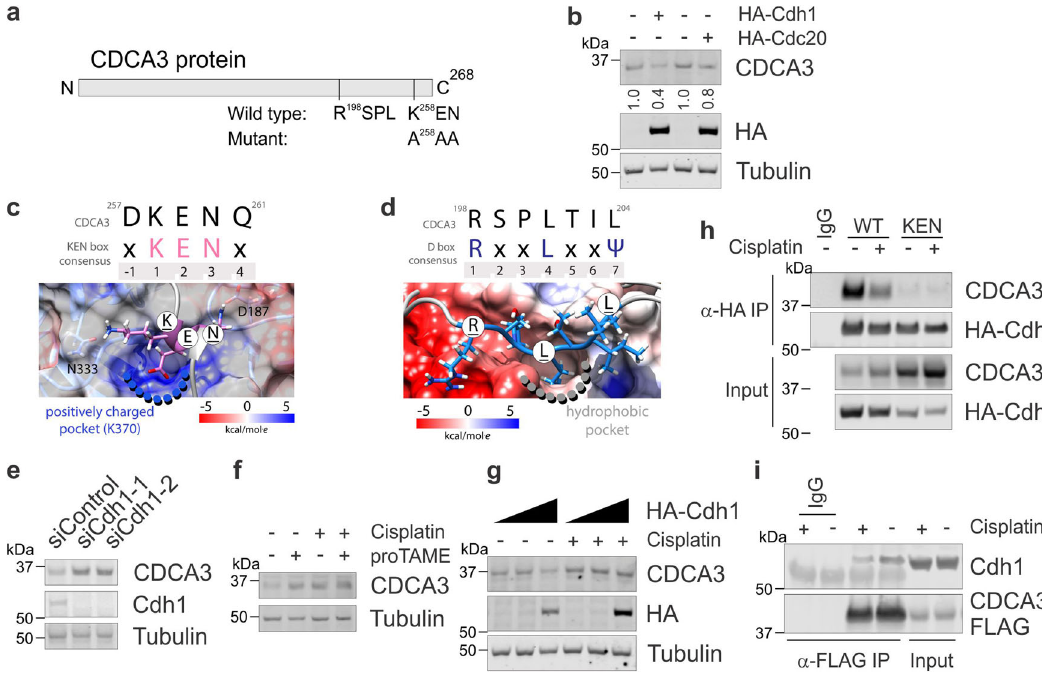
Fig. 3 CDCA3 avoids APC/C Cdh1 -mediated degradation following exposure to cisplatin. a Schematic of primary CDCA3 protein sequence listing C- terminal D-box (RxxL) and KEN box motifs. KEN box mutated to A 258 AA also indicated. b Endogenous CDCA3 western blot analysis of H460 cells ectopically expressing increasing levels of HA-Cdh1 or HA-CDC20. Tubulin used as loading control and HA probe to determine ectopic Cdh1 or CDC20 expression. c , d In silico models of the CDCA3 KEN box ( c ) and D-box ( d ) bound to Cdh1. Snapshots were taken after 300 ns of molecular dynamics simulation. Upper, CDCA3 protein sequence compared with consensus motifs. X = any amino acid, Ψ = aliphatic amino acid. Numbers indicate amino acid position within motif. Lower , colour scales highlighting the Columbic electrostatic potential at the surface of Cdh1 in these functional regions. e Western blot analysis of endogenous CDCA3 in control or Cdh1 depleted H460 cells. f Endogenous CDCA3 western blot analysis of H460 cells treated with cisplatin, the APC/C inhibitor proTAME or combination of both. g Western blot analysis of H460 cells expressing increasing levels of ectopic HA-Cdh1, as per Fig. 3b, treated with or without cisplatin. h Immunoprecipitation analysis of ectopic HA-Cdh1 with wild-type or KEN mutant CDCA3-FLAG from H460 cells treated with or without cisplatin. i Reciprocal immunoprecipitation analysis of ectopic CDCA3-FLAG with endogenous Cdh1 in H460 cells treated with or without cisplatin. All in vitro experiments are representative of three independent